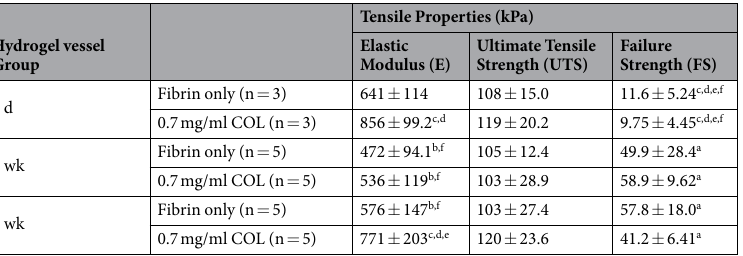
Table 3. Circumferential tensile properties of adventitia vessels cultured for 1 day, 1 week and 2 week periods. All groups used human fibroblasts for seeding of the 6-ring stack vessels and cytokine stimulation with TGF- β and ascorbic acid. a Denotes statistical significance to fibrin only – 1 d (p ≤ 0.05). b Denotes statistical significance to 0.7 mg/ml COL – 1 d (E: p ≤ 0.01; FS: p ≤ 0.05). c Denotes statistical significance to fibrin only – 1 wk (p ≤ 0.05). d Denotes statistical significance to 0.7 mg/ml COL – 1 wk (E: p ≤ 0.05; FS: p ≤ 0.001). e